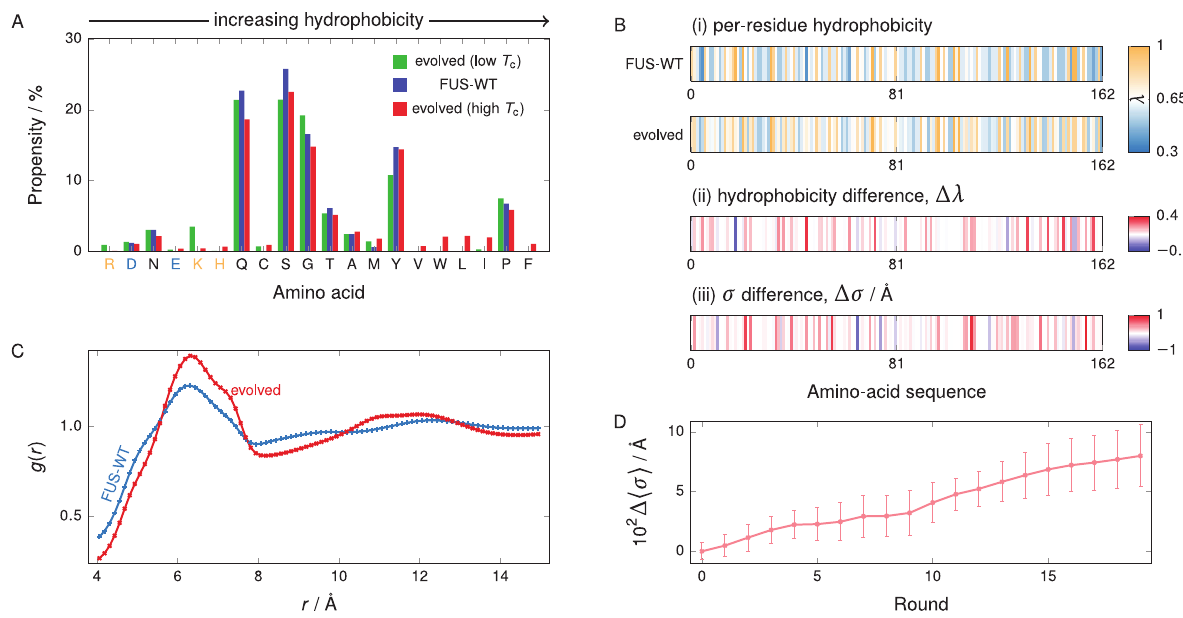
Fig 2. Properties of evolved FUS PLD. (A) Amino-acid composition before and after applying the genetic algorithm to increase and reduce the phase diagram width, and hence the critical temperature, starting from WT-FUS. Amino acids are plotted in order of increasing hydrophobicity [see Table A in S1 Text]. Positively charged amino acids are indicated in light orange and negatively ones in light blue. In genetic-algorithm runs which increase T c , hydrophobic amino acids become favoured, whilst the converse holds for genetic-algorithm runs which decrease T c . (B) Map of (i) the per-residue hydrophobicity along the sequence, (ii) the change from the wild type to the evolved protein after evolution towards higher T c and (iii) the change of the per-residue amino-acid size ( σ ). The data for the evolved protein are averaged over the entire population at the end of 3 independent genetic-algorithm runs. No larger-scale regional preference for modification is readily apparent. Trends in hydrophobicity and σ are largely correlated. (C) Comparison of the pair correlation function g ( r ) before and after evolving FUS with a genetic algorithm towards a larger phase diagram width. The data were computed at the same bead number density N / V = 7.0 nm − 3 and temperature T ¼ 0 : 8 T wt . In both cases, this c temperature is below the critical point and the density corresponds to the protein-rich (liquid-like) phase, i.e. a point that lies above the binodal line on the phase diagram. We compute g ( r ) by finding for each bead i in the system the number of all non-harmonically bonded other beads within a distance r + δ r of the each other for bins of width δ r , averaging over each bead i in the system, and normalising the result by the volume element and the (common) number density. The symbol size is larger than the standard deviation of the average across 4 independent simulations. In the case of the evolved system, the more pronounced nearest-neighbour maximum indicates the local environment is more structured than in the case of WT-FUS. (D) The average σ value of the amino acids in the population increases over the course of the genetic-algorithm run. Error bars are standard deviations of the averaged σ value of individual sequences with respect to the pooled population from the three genetic-algorithm runs.